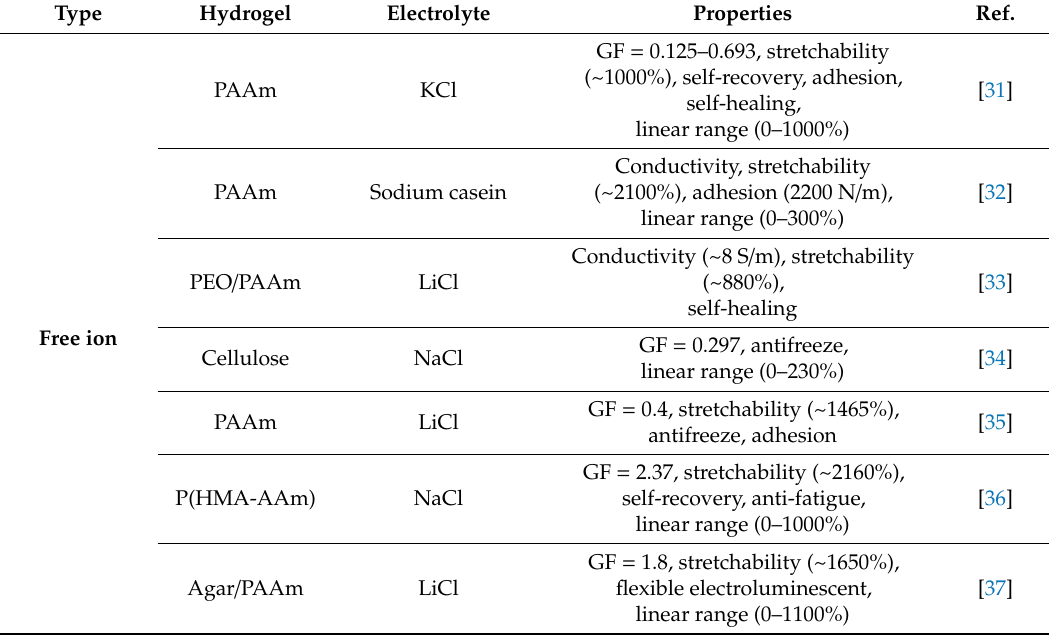
Table 1. Summary of the performance of reported various ionic conductive hydrogel used as flexible strain